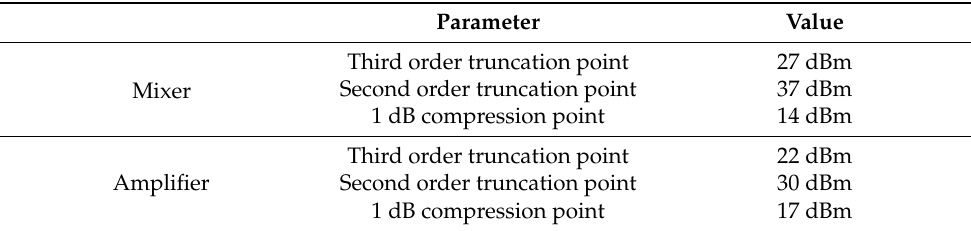
Table 7. Nonlinear parameter index of transmitting